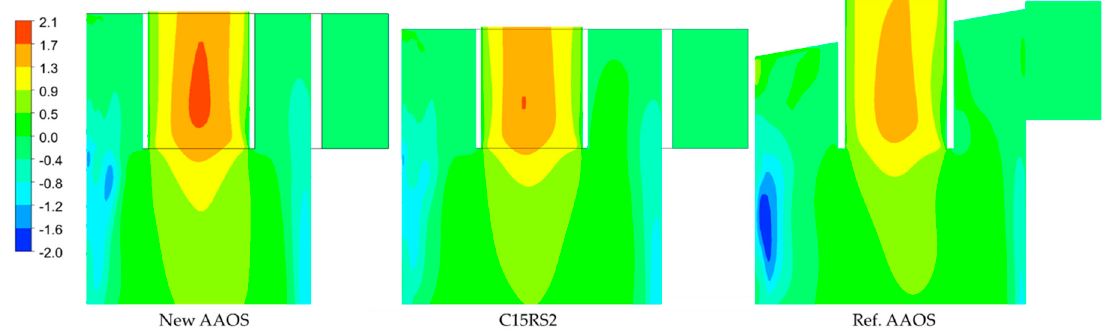
Figure 16. Time-averaged tangential velocity—plane 1 − 1.